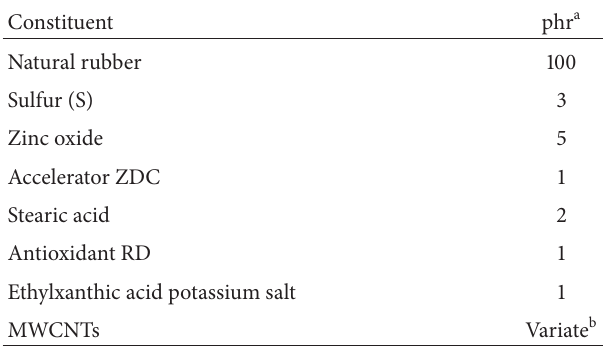
Table 1: The composition of